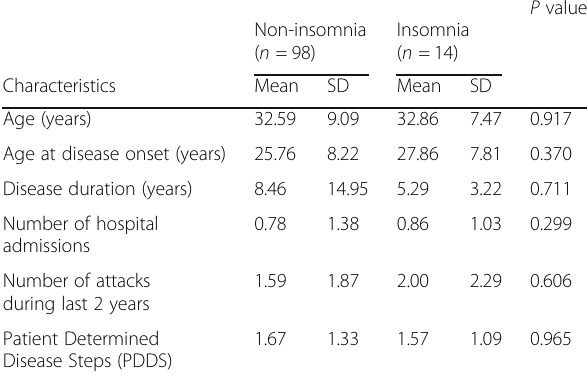
Table 1 Demographic and clinical characteristics of study non-depressed MS patients ( n = 112) Characteristics